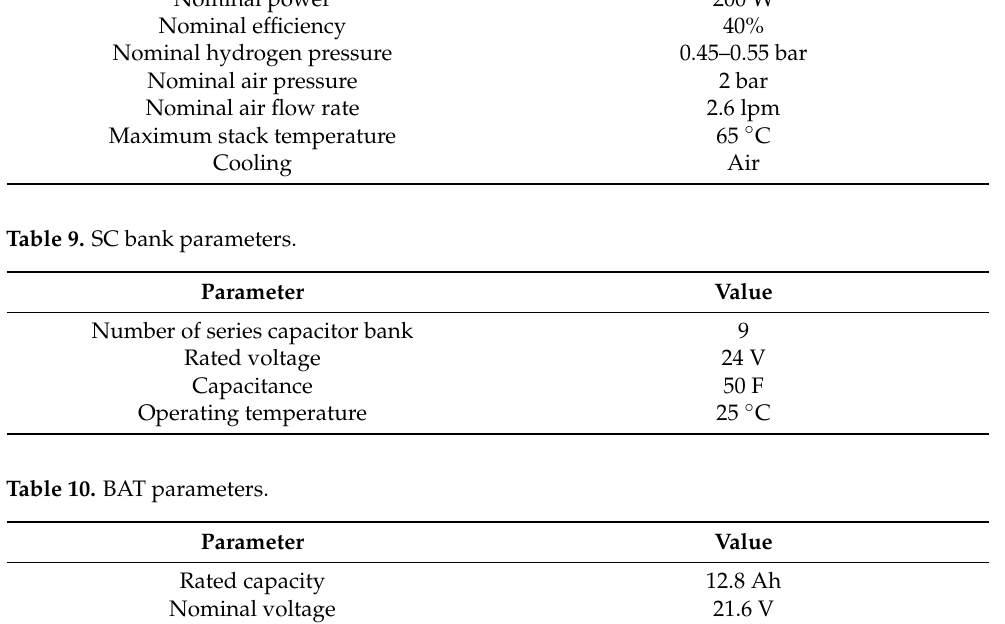
Figure 17. The simulation model of the proposed EMS.